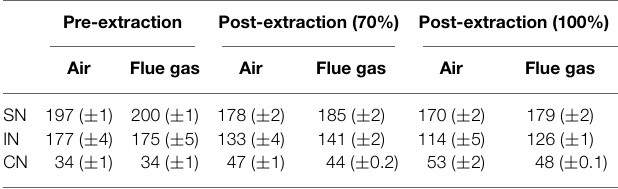
TABLE 3 | Calculated values for estimated biodiesel quality based on FAME profiles for Heterosigma akashiwo grown on air (control) or simulated flue gas (treatment)